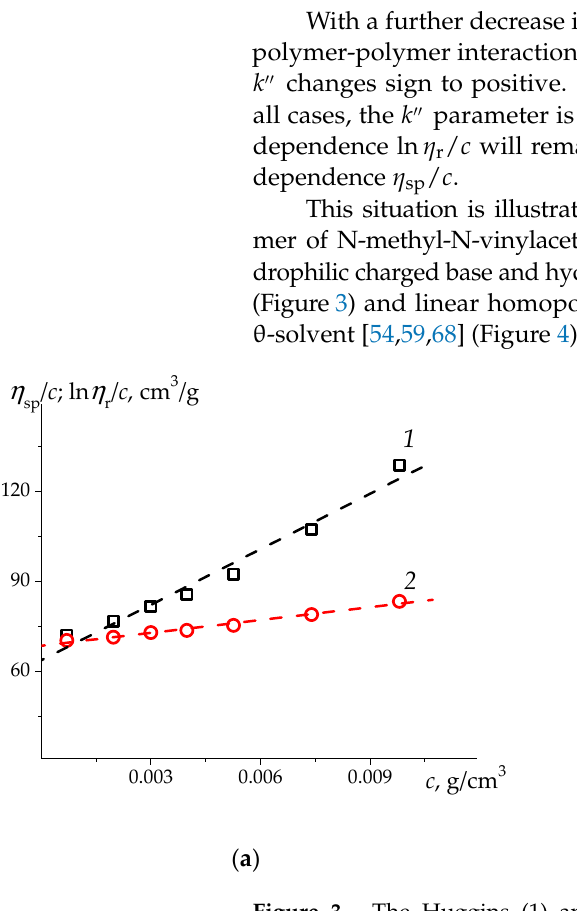
Figure 3. The Huggins (1) and Kraemer (2) plots for alkylated copolymer of N-methyl-N-vinylacetamide and N-methyl-N-vinylamine (MVAA- co -MVAC 12 H 25 ) [55,61] (Sample 4 in Table 4) in aqueous 0.1 M NaCl solution at 25 ◦ C: ( a )—in the range of relative viscosities 1.05 < η r < 2.25 ( [ η ] H = ( 64 ± 3 ) cm 3 /g, k (cid:48) = 1.5 ± 0.2, r = 0.9863; [ η ] K = ( 68.6 ± 0.5 ) cm 3 /g, k (cid:48)(cid:48) = +( 0.30 ± 0.02 ) , r = 0.9917); and ( b )—in the entire range of concentrations 1.05 < η r < 6.35 (Line 3 is drawn as a tangent to the 2-nd degree polynomial fit in the initial range of values η r < 1.5, its values: = 68.9 cm 3 /g, k (cid:48) = 0.88. Overall parabola (1) demonstrates the curvature of dependence of [ η ] H corr corr η sp / c in contrast with one of ln η r / c in the entire interval 1.05 < η r <